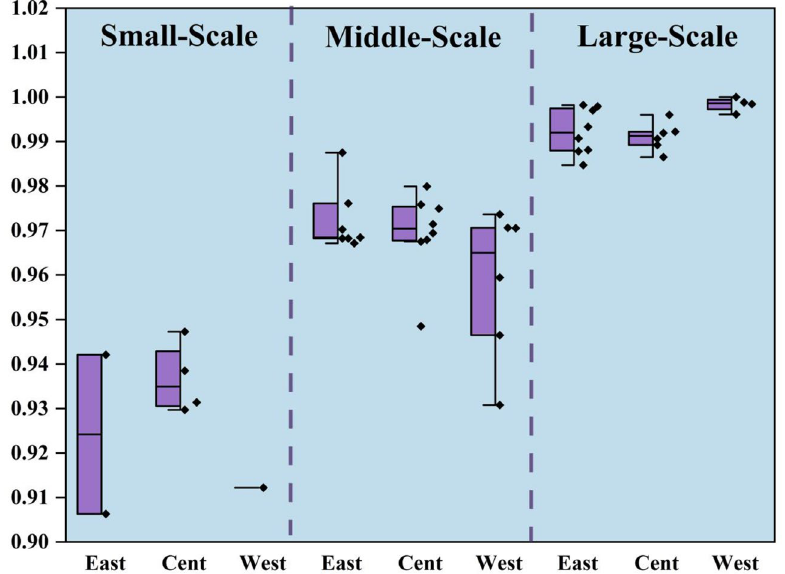
Figure 7. Three-scaled TGR in distinctive